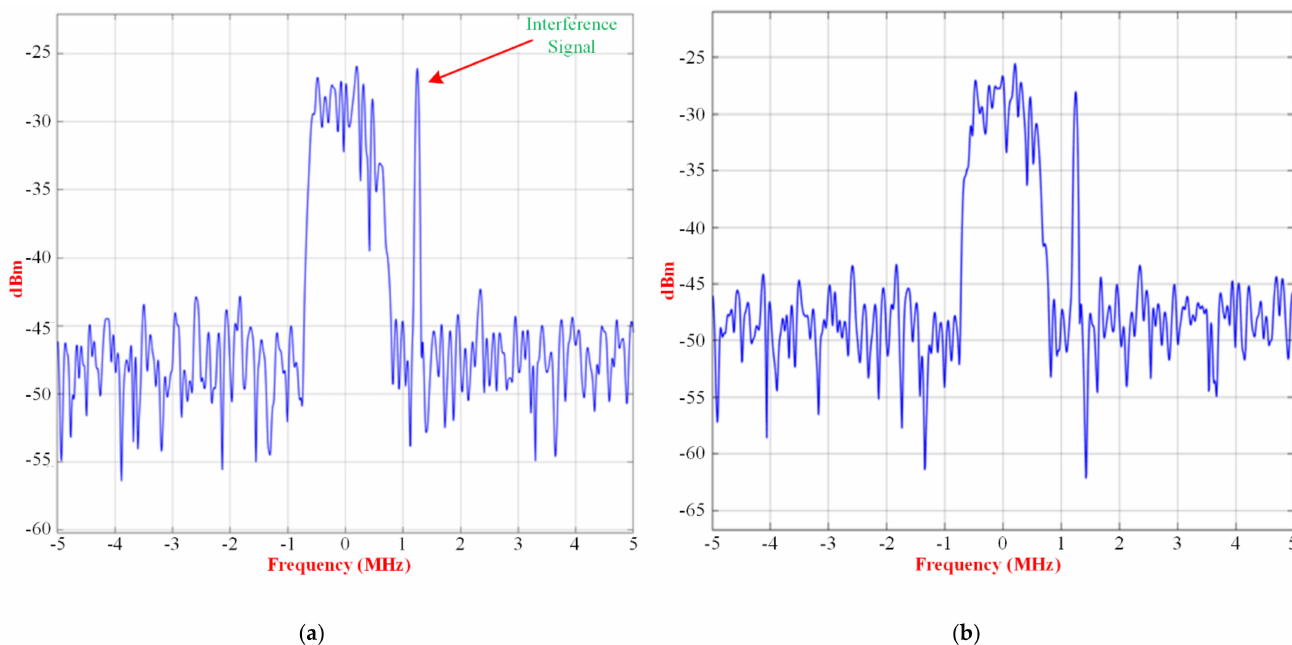
Figure 26. Signal and interference input spectrum of the RF receiver for case 2 ( a ) without beamform- ing, and ( b ) with beamforming.